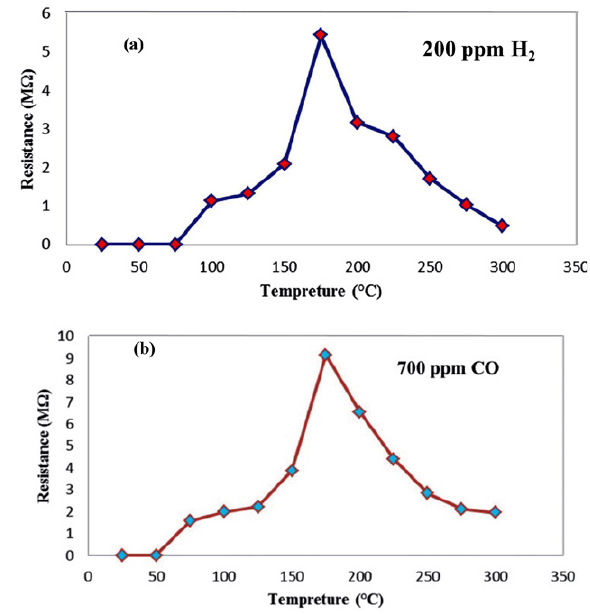
Figure 7 . Responses of the calcinated CuO nanofibers sensors to (a) 200 ppm of H 2 and (b) 700 ppm of CO at different operating tem- peratures.